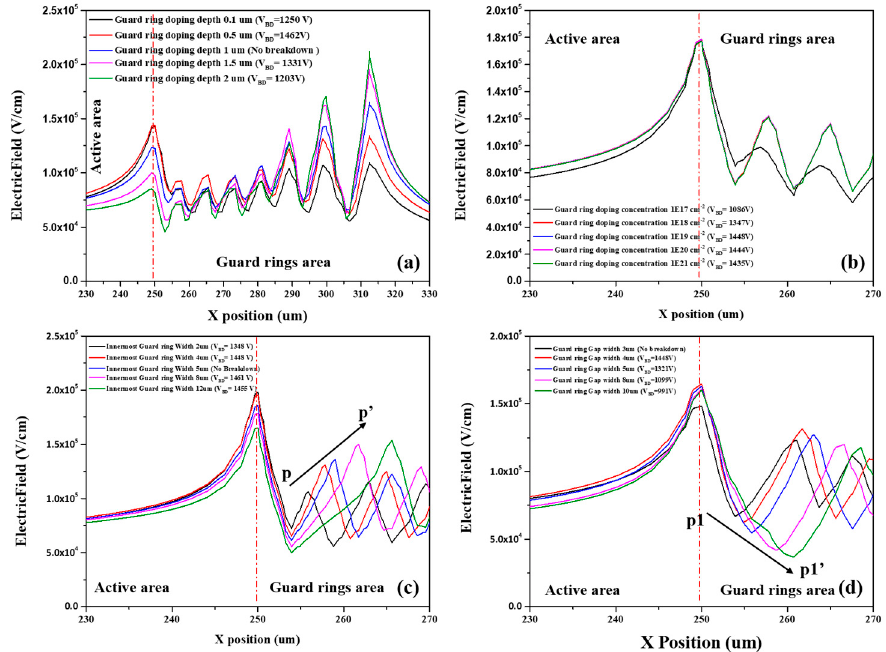
Figure 9. The electric field distribution at the depth of 0.1 µ m under the device surface: ( a ) guard ring doping depth, ( b ) guard ring doping concentration, ( c ) innermost guard ring width, and ( d ) gap width between the active area and innermost guard ring. The red line represents the edge of the active area and pp’, p1p1’ indicates the peak amplitude change.